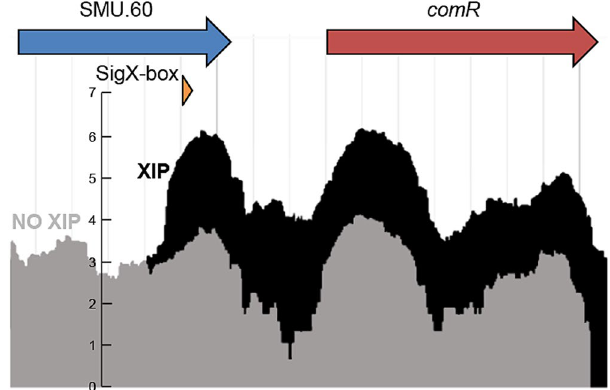
Figure 4. Transcriptome map showing expression of comR and its upstream region in S. mutans Δ comS grown in the presence (black) or absence (light gray) of XIP in chemically defined medium. The images are superimposed to illustrate the differences in expression between the two conditions, starting next to the predicted intragenic SigX box. The axis on the left represent the log 2 average of read counts of normalized individual duplicated samples for each condition, as detailed in material and methods.